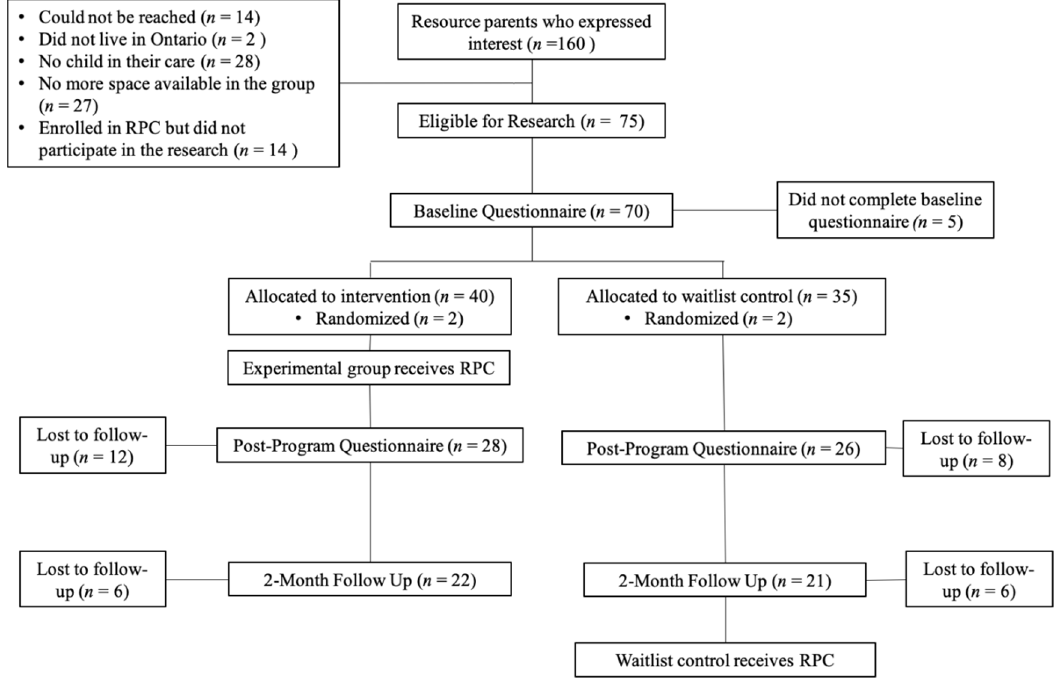
Figure 1. Flow Chart of the Study’s Progress, Including Recruitment, Participation, and Attrition.